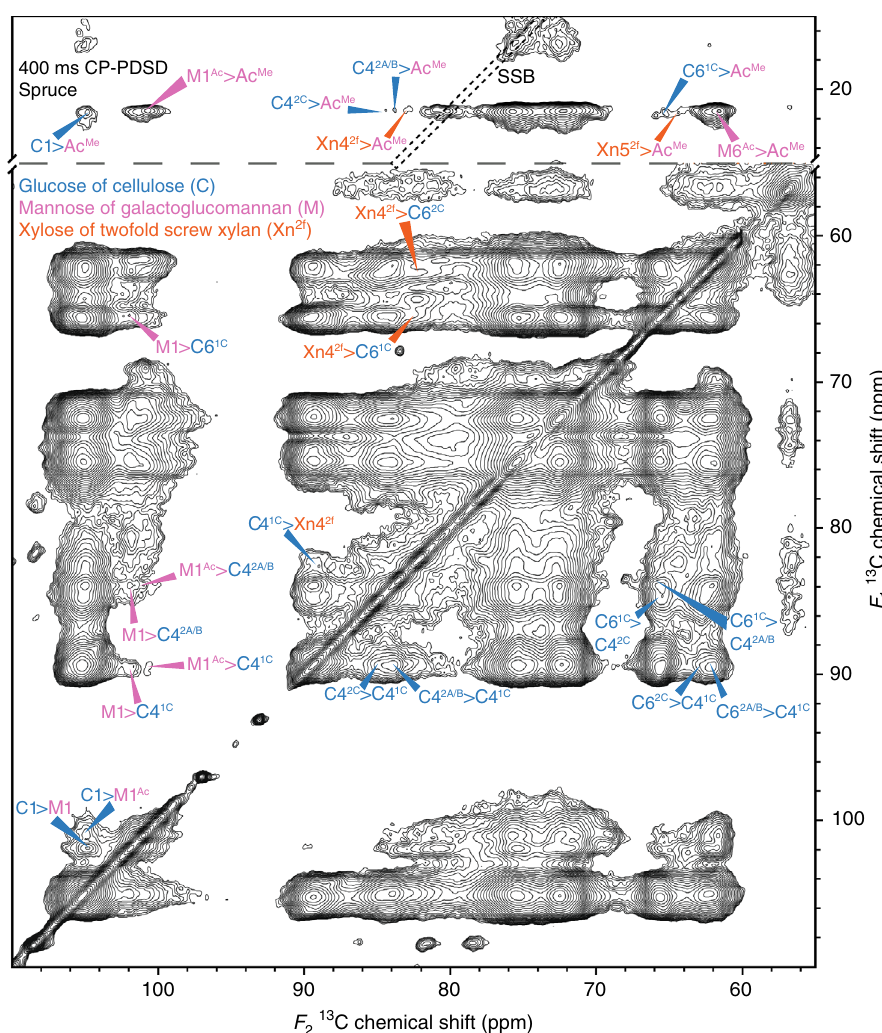
Fig. 3 Xylan and GGM are a similar distance from the cellulose micro fi bril surface as glucan chains are from each other. The acetate methyl and carbohydrate regions of a 400 ms mixing time CP-PDSD 13 C MAS NMR spectrum of spruce is shown. Cross-peaks between the different cellulose domains are labelled on the right hand side of the diagonal line in the carbohydrate region. Cross-peaks between cellulose and xylan/GGM are labelled on the left hand side of the diagonal line in the carbohydrate region and in the acetate methyl region of the spectra. Spinning side bands are surrounded by black dotted lines and are marked